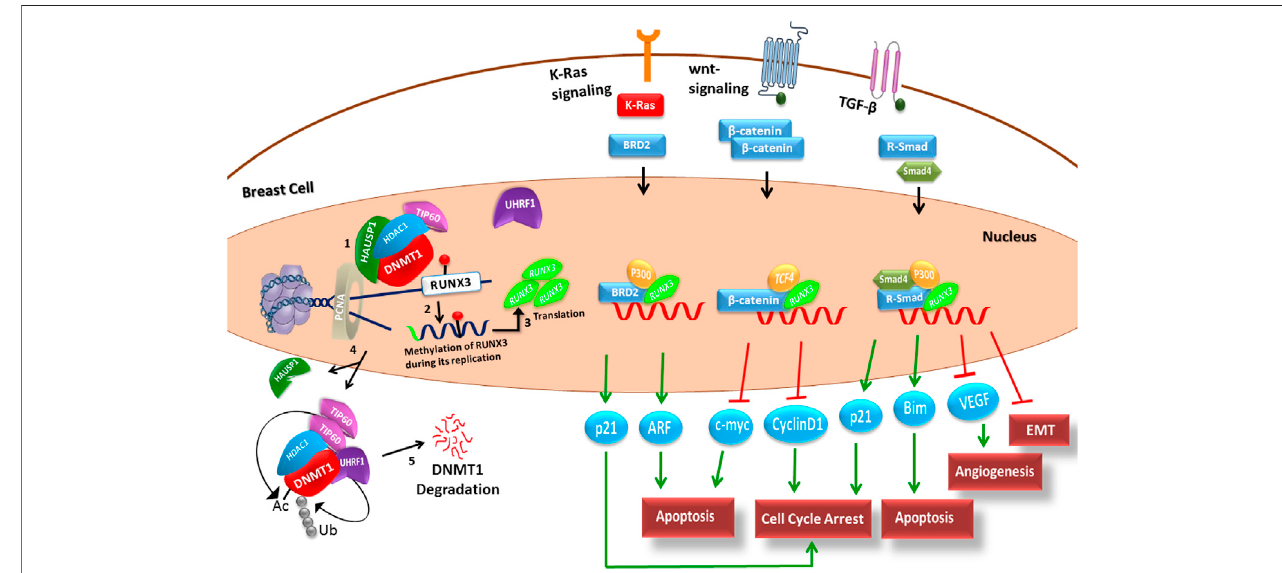
FIGURE2| Schematicknowledge-based networkispresentedtoillustratethestepwise processofreplicationandmethylation(byDNMT1) ofTSG RUNX3 andits implication in different cancer pathways. Step 1: At the replication fork, UHRF1 recognizes hemimethylated DNA and recruits other proteins including DNMT1, Tip60, HAUSP1, HDAC1, and PCNA to make a macroprotein complex. Step 2: DNMT1 in complex with these regulators transfers a methyl group through the base fl ip mechanism onto the nascent daughter strand. The green color highlighted in the daughter strand depicts the hypomethylated promoter region of the nascent RUNX3 gene. The red-headed lollipop structure here mimics the normal methylation status of RUNX3 gene. Step 3: Transcription machinery then successfully identi fi es the promoter region to translate the functional RUNX3 protein, which acts as a tumor suppressor and combats the cancerous environment through the regulation of major signaling pathways including TGF-beta, Wnt/ β , and KRAS pathways. TSG RUNX3 exerts its antitumor activity by regulating the transcription of signi fi cant target genes including p21, c-myc, and p53 (oval blue structures at the bottom). Steps 4 and 5: The entire macroprotein complex after performing its function undergoes stepwise proteasomal degradation in the late S-phase of cell cycle. PCNA = proliferating cell nuclear antigen; DNMT1 = DNA methyltransferase 1; HAUSP1 = herpesvirus-associated ubiquitin-speci fi c protease; HDAC1 = histone deacetylase1; Tip60 = histone acetyltransferase; UHRF1 = ubiquitin-like, containing PHD